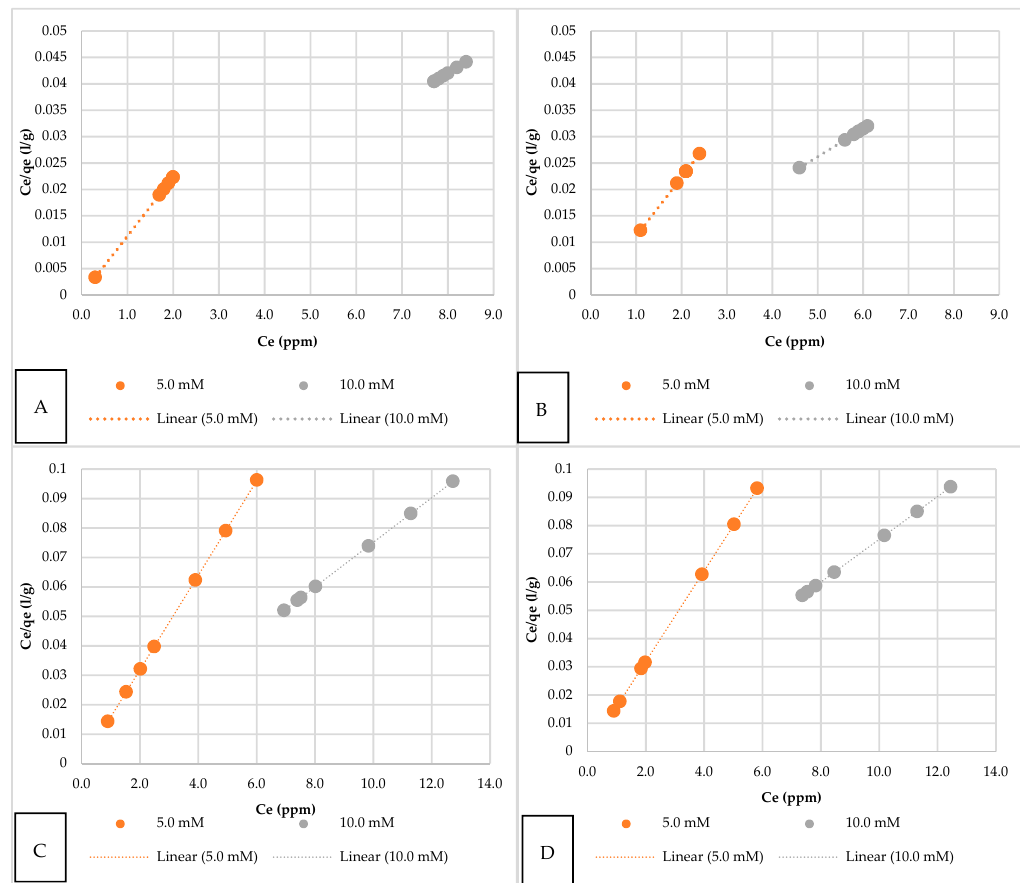
Figure 5. Pseudo-second-order Langmuir isothermal plots for virgin and irradiated AMP (top left and top right, A , B ), and virgin and irradiated AMP-PAN (bottom left and bottom right, C , D ), calculated from the data in Figure 3A–D.